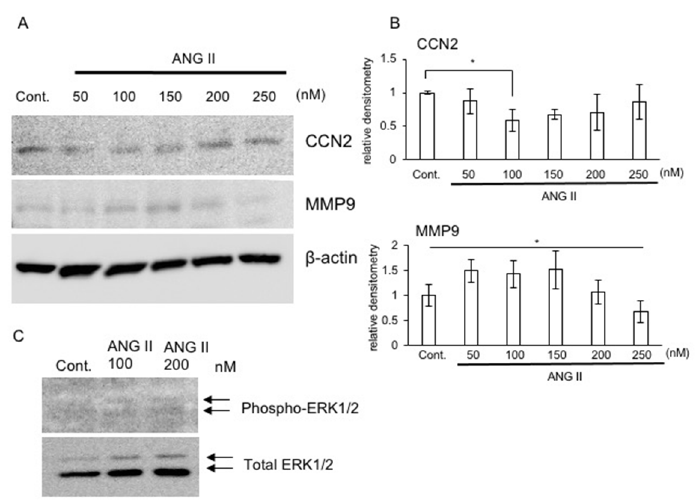
Figure 2. ( A ) Effect of ANG II on the production of CCN2 and MMP9 in HCS-2/8 cells. HCS-2/8 cells were treated with ANG II at the indicated concentrations for 24 h. Then, Western blot analysis was performed. ( B ) The amounts of CCN2 and MMP9 were determined densitometrically and these amounts were normalized to the amount of β -actin. Relative densitometry (control = 1.0) from 4 measurements is presented and was analyzed by Bonferroni’s test and one-way ANOVA. The asterisk indicates a significant difference from the control at * p < 0.05. ( C ) Activation of ERK-1/2 in RCS cells treated with ANG II. RCS cells were treated with ANG II at the indicated concentrations for 15 and 30 min. Western blot analysis was performed with antibodies against the indicated proteins.